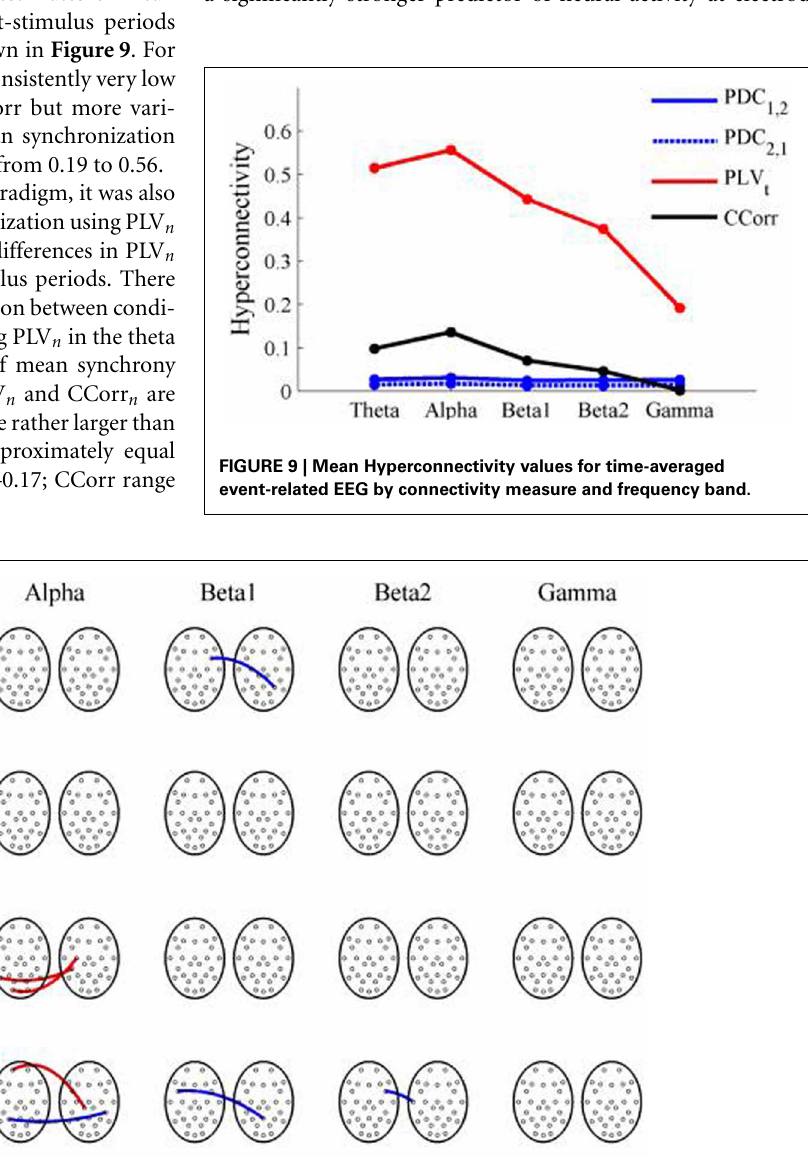
that there was a significant change in connectivity from the pre- to the post-stimulus periods between the first member of a pseudo-pair and the second member. Red lines indicate an increase in connectivity from the pre- to the post-stimulus period and blue lines indicate a decrease. For PDC 1 , 2 , lines connecting electrode sites between the heads show that neural activity in the first member of a pseudo pair was more predictive of the neural activity of the second member of the pair in the post-stimulus period than in the pre-stimulus period. Allocation to first or second member of the pseudo-pair was